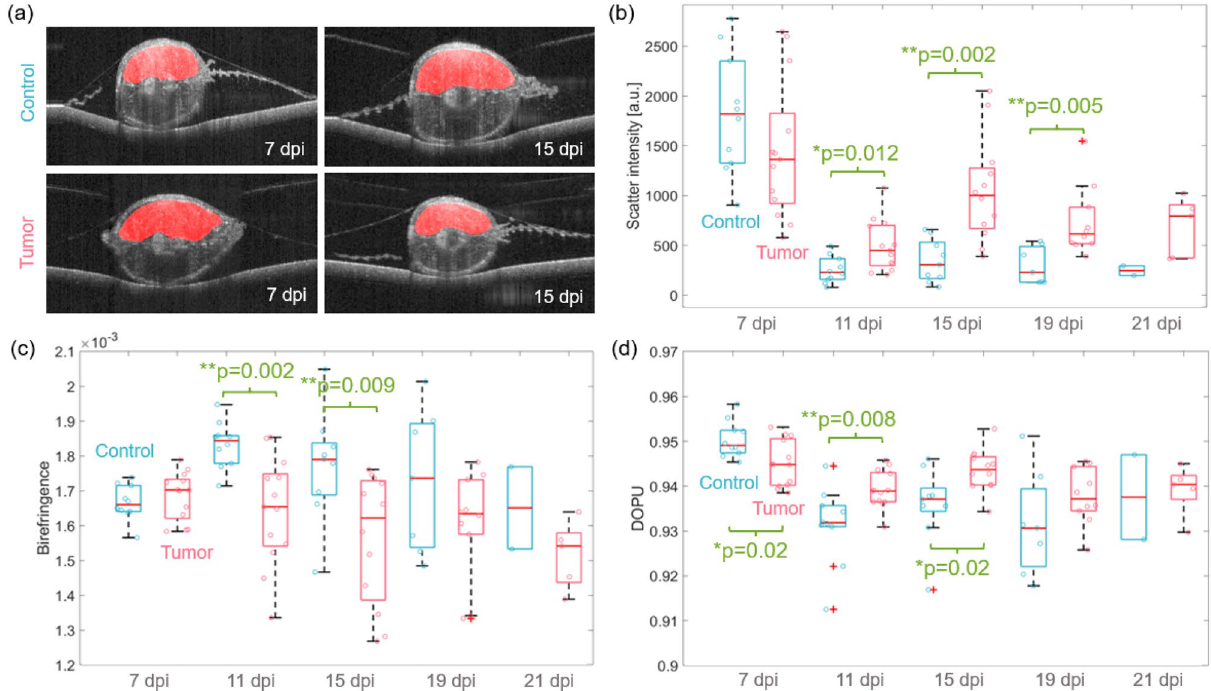
Figure 4. The scatter and polarization analysis. ( a ) Representative scatter-intensity B-scan images of control and tumor zebrafish overlaid with the automatic muscle segmentation results (red). ( b ) Box-whisker plots of the mean intensity values over the five measurement days post injection (dpi) in control and tumor animals. ( c , d ) Box-whisker plots of the mean birefringence and DOPU values. Each data point represents the mean value of the respective quantity for each animal